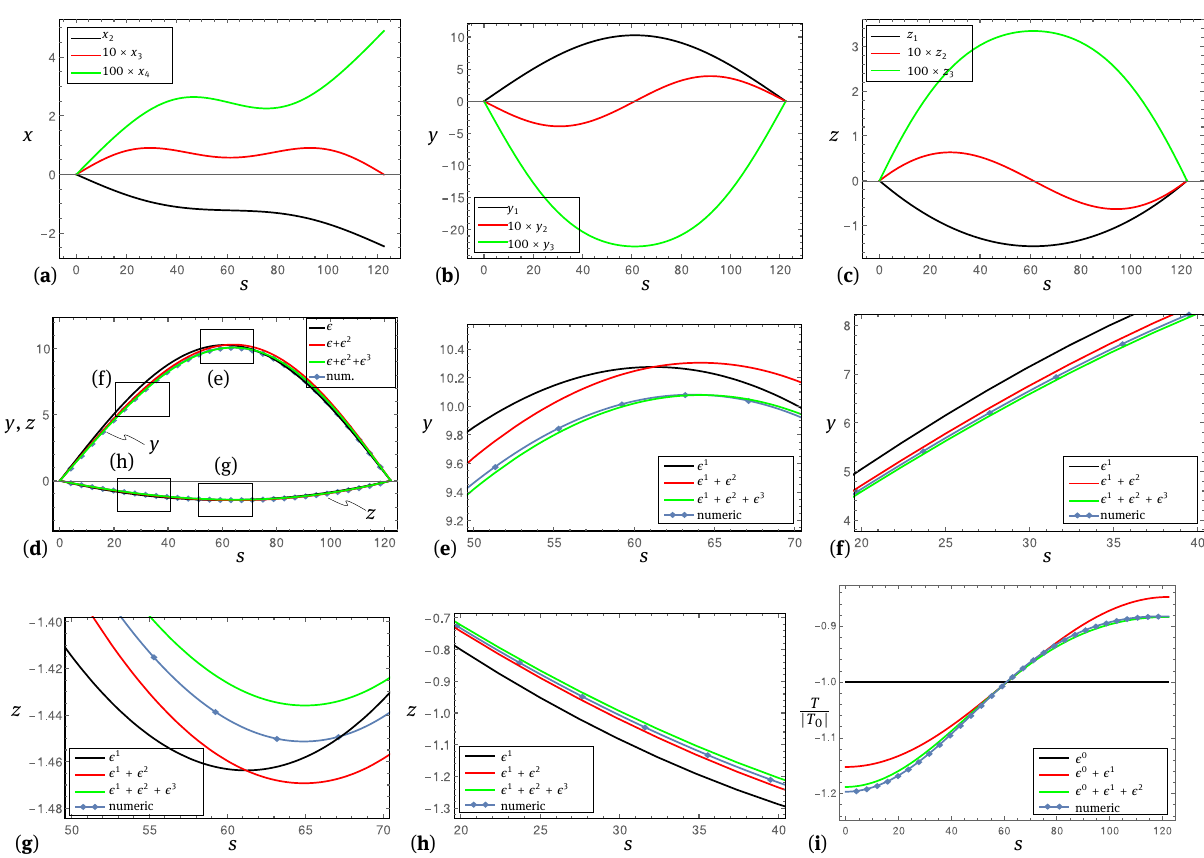
Figure B1: Case study, negative T 0 : (a) solution x ( s ) ; (b) solution y ( s ) ; (c) solution z ( s ) ; (d) reconstituted y and z , complete view and zoom windows for subfigures (e), (f), (g), (h); (e) reconstituted y close to the mid-span; (f) reconstituted y close to quarter-span; (g) reconstituted z close to the mid-span; (h) reconstituted z close to quarter-span; (i) force ratio T ( s )/ | T 0 | ; [ s , y , z ] = m